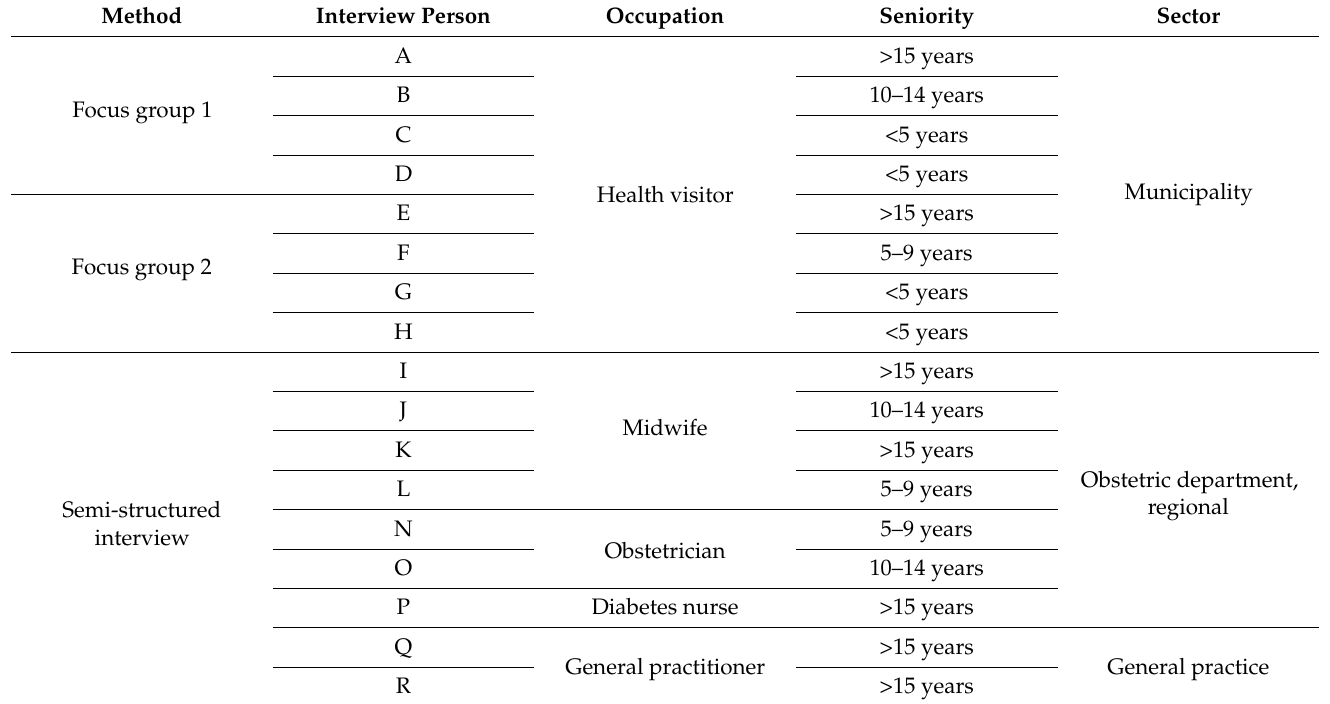
Table 2. Background characteristics of participating healthcare professionals.